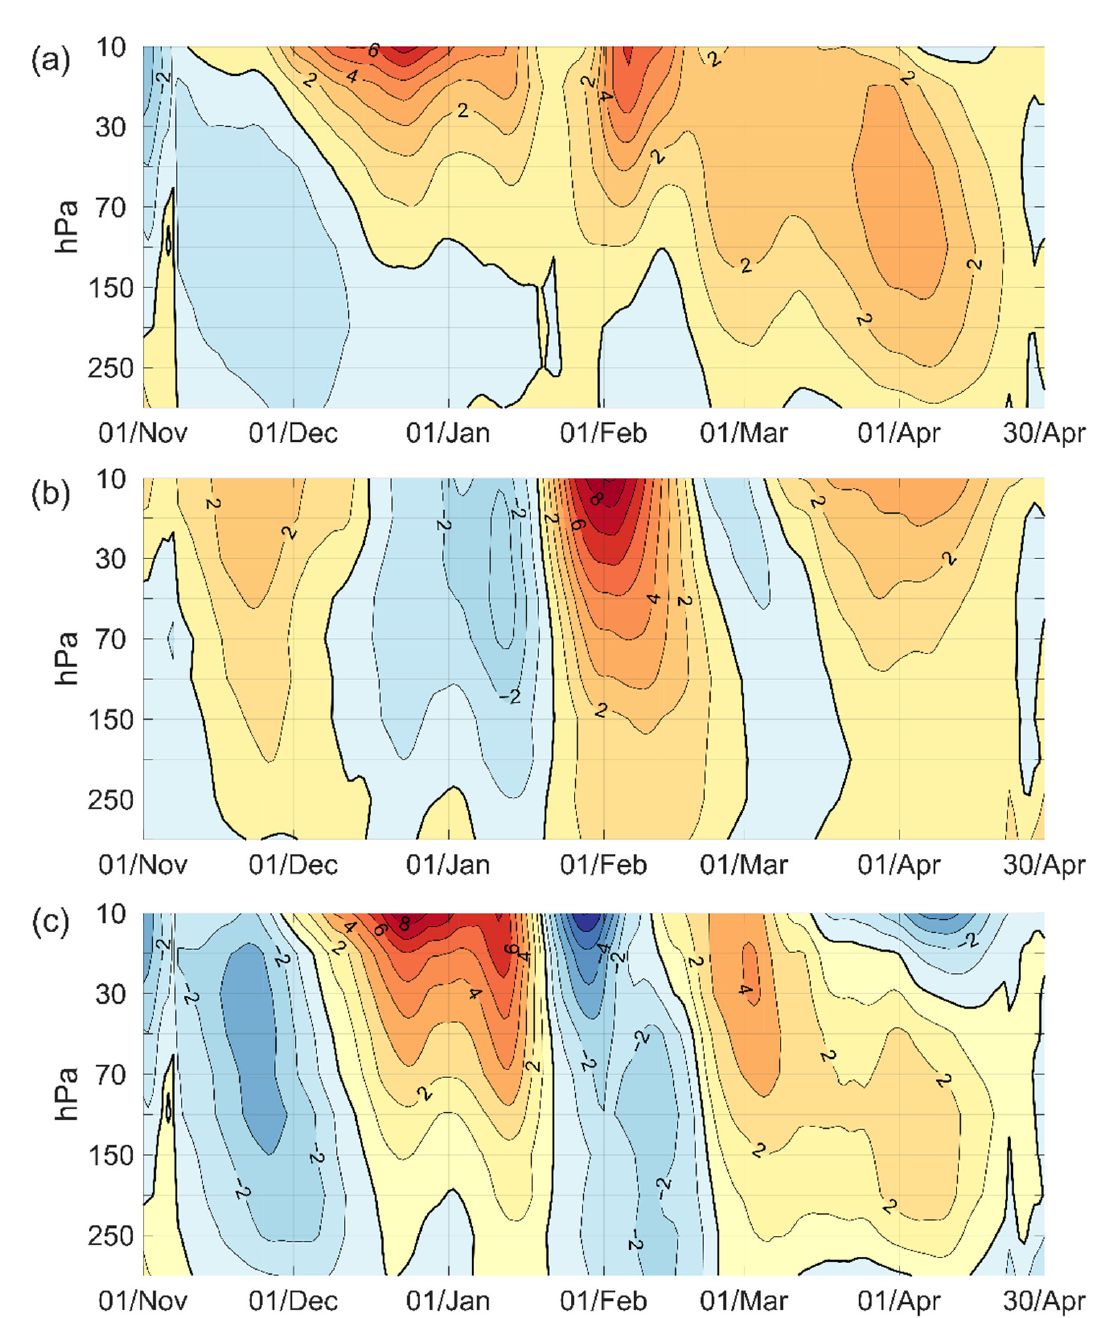
Figure 6. Composite vertical sections of daily anomalies in Arctic stratospheric temperatures averaged between 70 and 90° N for ( a ) Eastern Pacific and ( b ) Central Pacific El Niño events and ( c ) difference between composites of EP and CP El Niño events. Values are smoothed with a 15-day running mean. Contour interval is 1K. Black bold line indicates zero isoline.